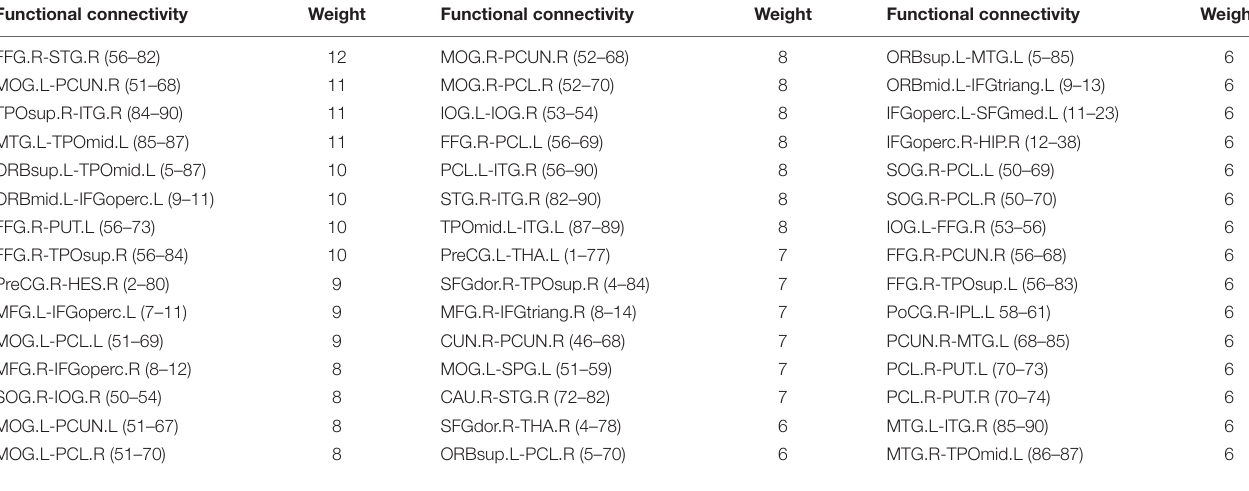
TABLE 4 | The key features with weight value greater than or equal to 6.